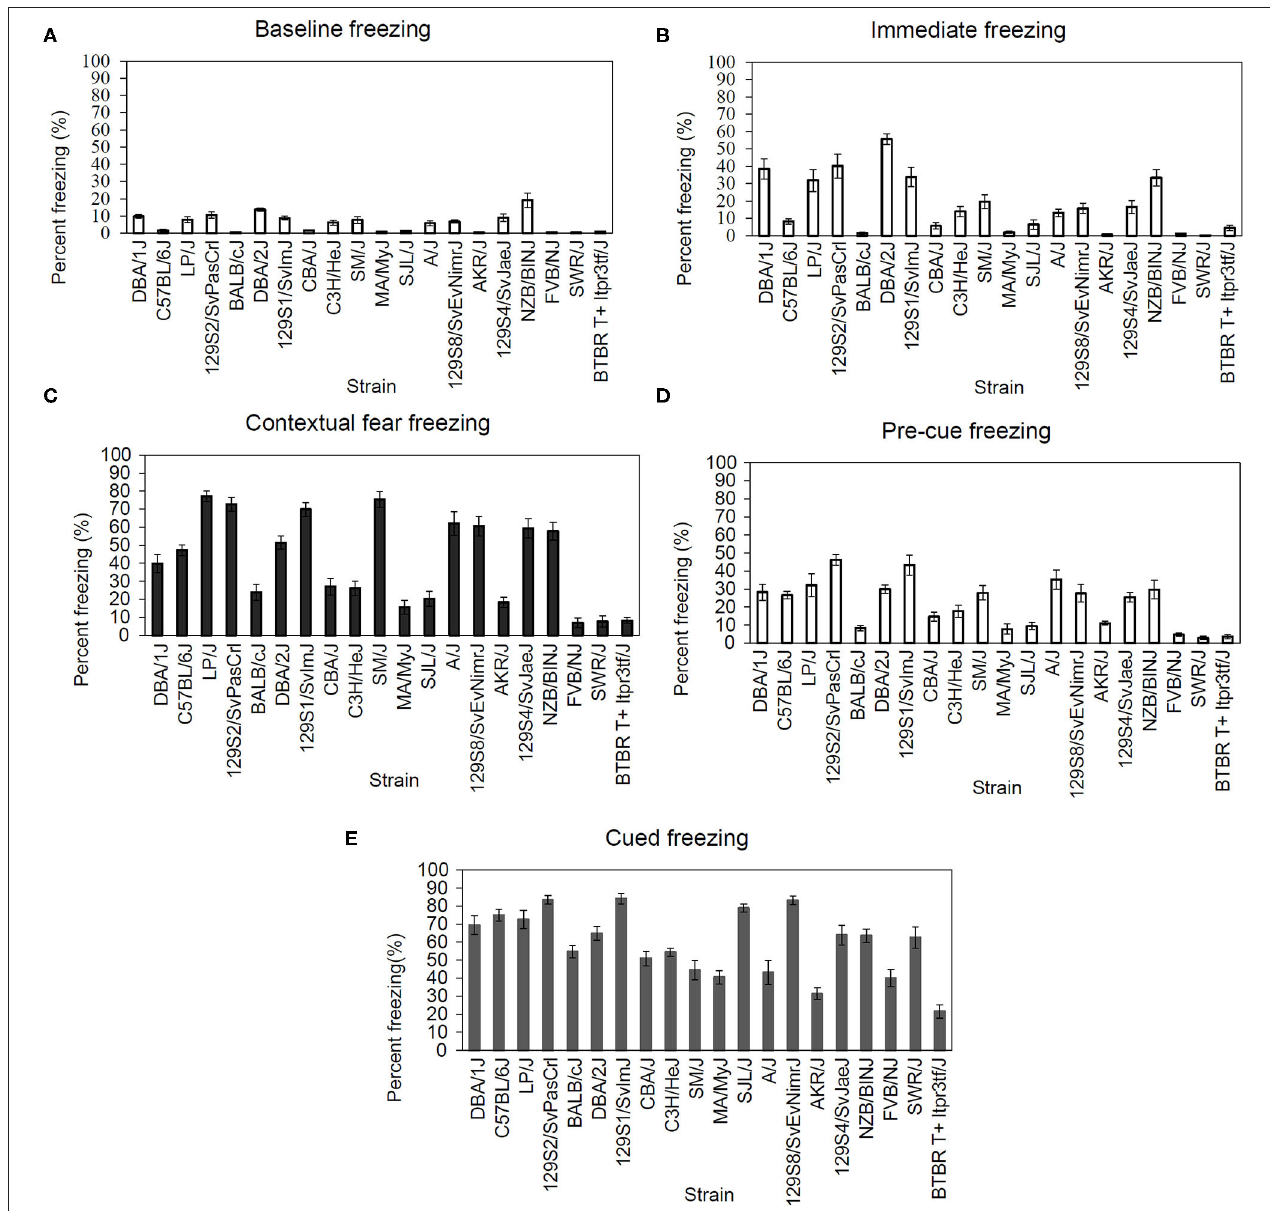
FIGURE 1 | Significant strain differences were present for all fear conditioning components. (A) Strain-dependent differences in baseline [ F (19,193) = 12.81, p < 0.05], (B) immediate [ F (19,193) = 20.27, p < 0.05], (C) contextual [ F (19,193) = 33.12, p < 0.05], (D) pre-cue [ F (19,193) = 13.19, p < 0.05], and (E) cued [ F (19,193) = 18.85, p